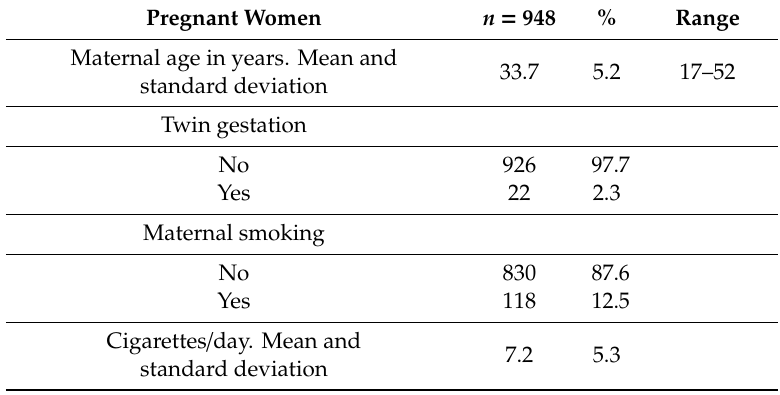
Table 1. Main characteristics of participants in the